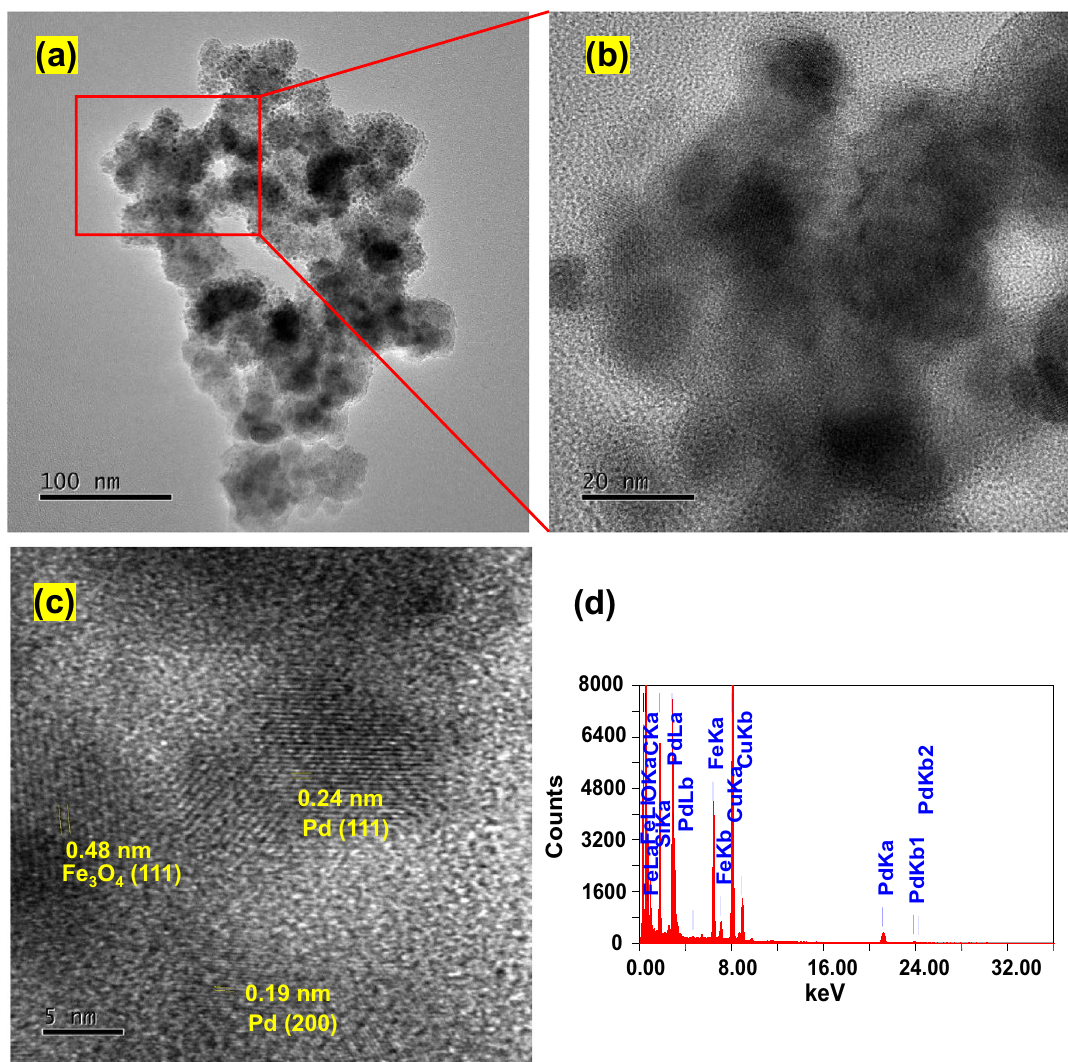
Figure 2. TEM and HRTEM images of Fe 3 O 4 @SiO 2 /Pd 0 /Pd II NP ( 5 )